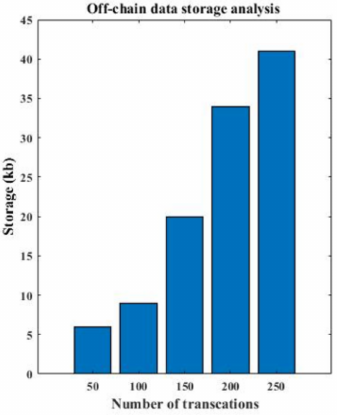
Figure 9. Execution time analysis of off-chain storage.